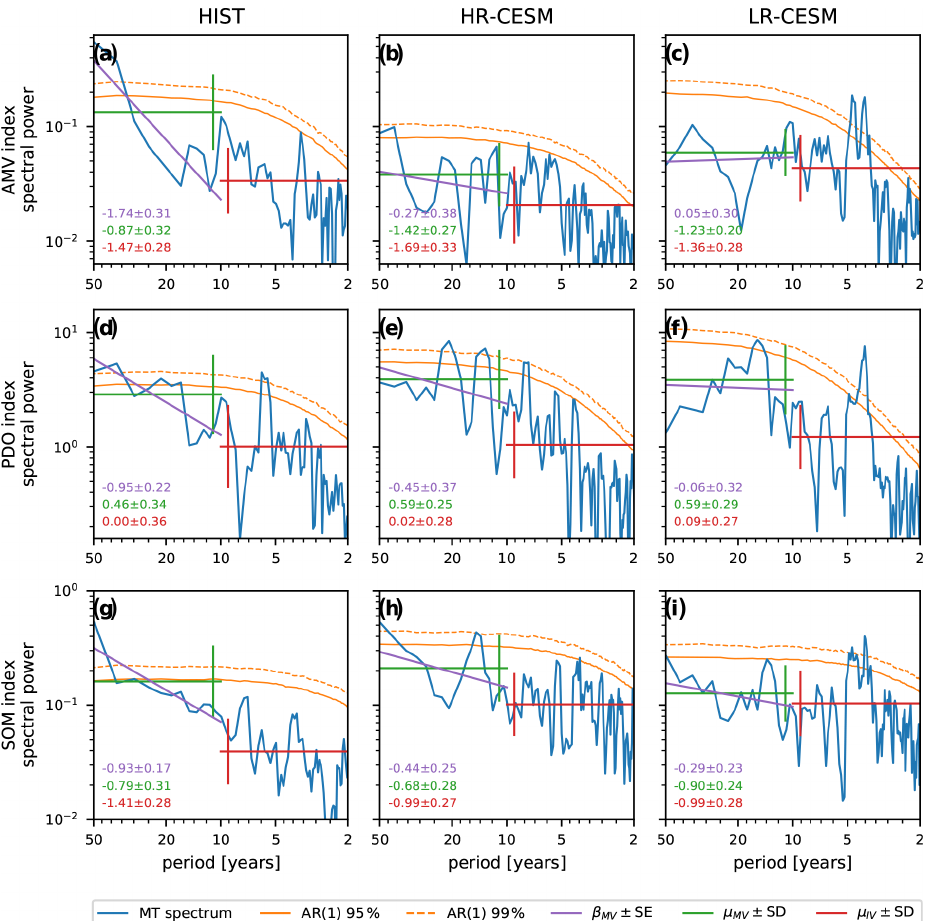
Figure 4. Multi-taper spectral estimates of the unfiltered monthly SST indices (blue) underlying the filtered time series of Fig. 2. Panels (a–c) show the AMV, (d–f) the PDO, and (g–i) the SOM index spectra for the two-factor detrended 149-year HadISST dataset (left) and the 250-year HR- and LR-CESM simulations (center and right, respectively). The units of the spectral power are K 2 yr for the SST average AMV and SOM indices and yr for the dimensionless PDO index. As a null hypothesis, 10000 AR(1) processes were simulated to estimate the 95% and 99% red noise confidence interval (solid and dashed orange lines). The purple line is a linear fit to the spectral slope β in the multidecadal variability (MV; 10–50 years) band. The horizontal green and red lines represent the mean spectral power µ in the MV and the interannual (IV; 2–10 years) bands, respectively. Numbers refer to β MV and its standard error (purple) and the decadic logarithm of µ MV / IV and their standard deviations (green and